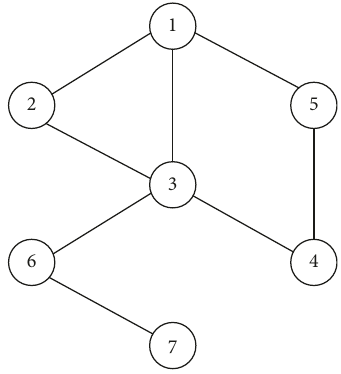
Figure 2: A running example for evaluating node in fl